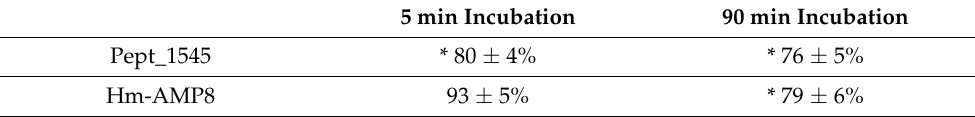
Decline in Peptide’s Sulfhydryl Groups as a Result of Peptide Incubation with MPO/H 2 O